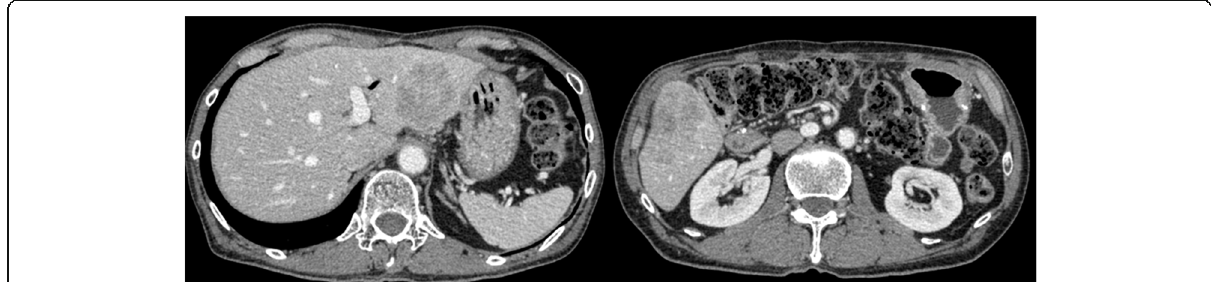
Fig. 7 Abdominal contrast-enhanced CT scan image at the hepatic resection after chemotherapy showing growth of colorectal liver metastases ( a , b